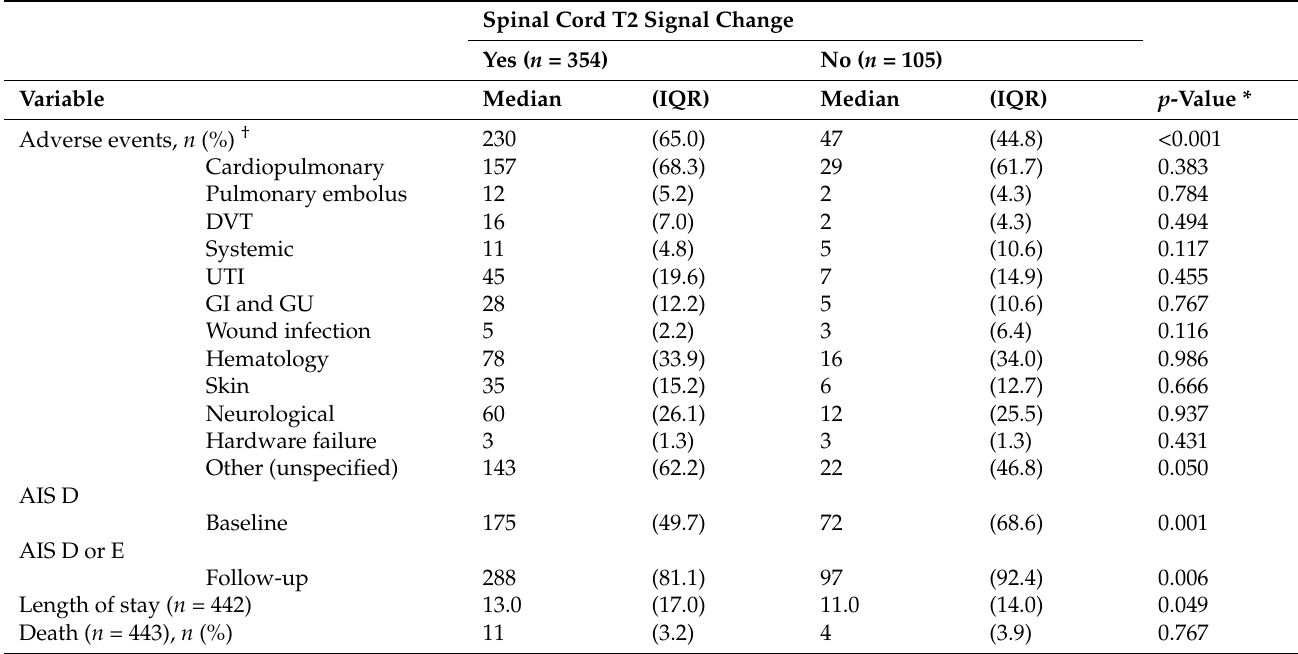
Table 3. Clinical outcome data for spinal cord injury patients stratified by radiographic spinal cord signal change ( n = 459).